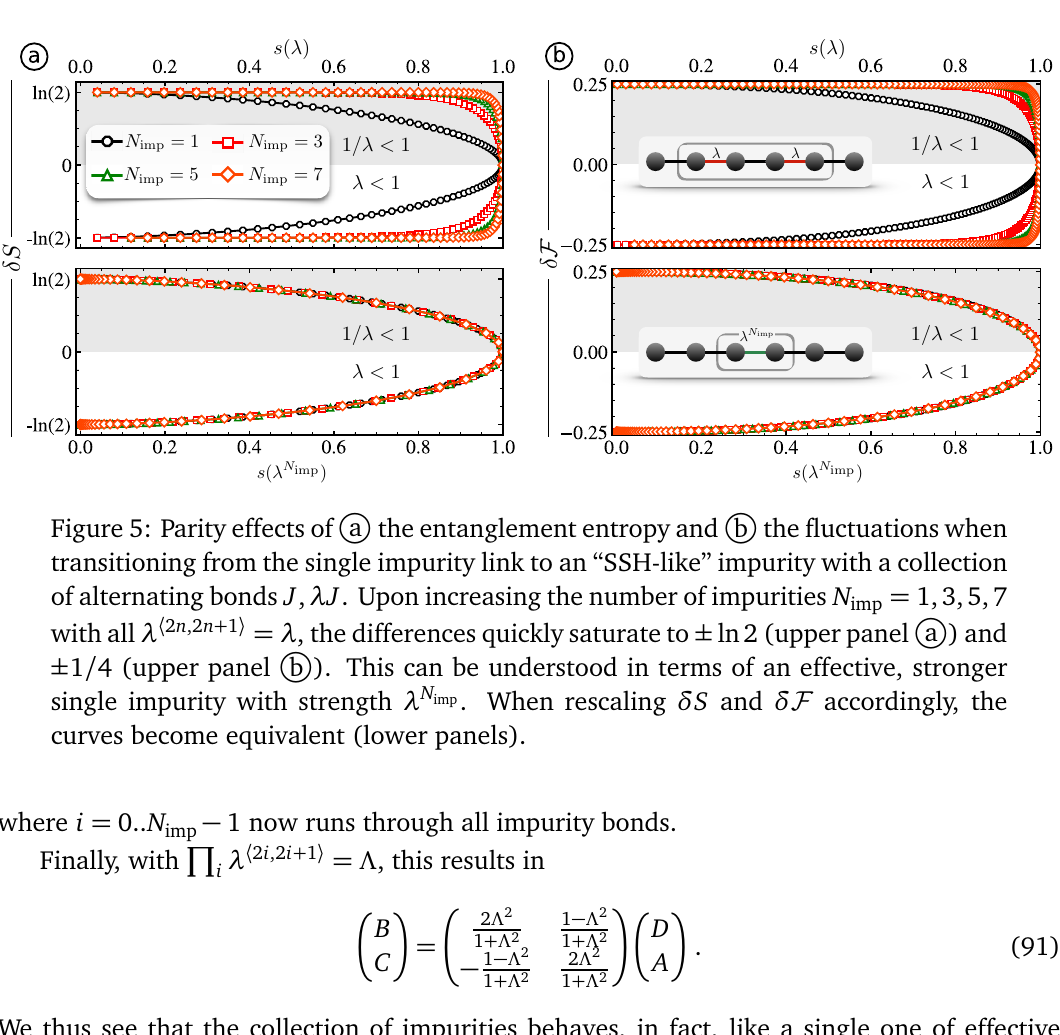
= 1,3,5,7 imp accordingly, the F